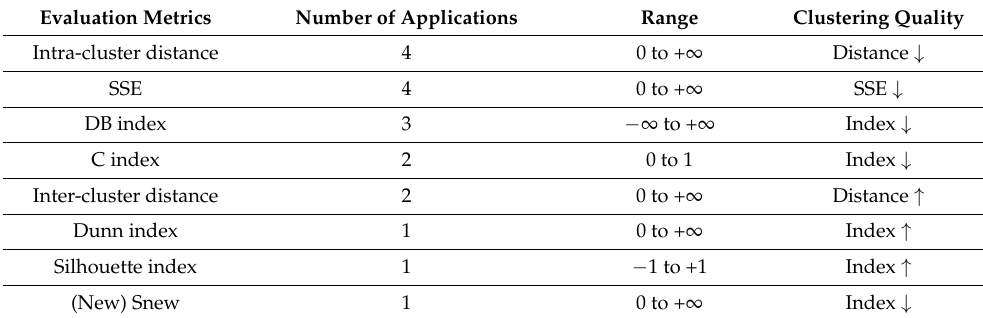
Table 4. Evaluation metrics for internal